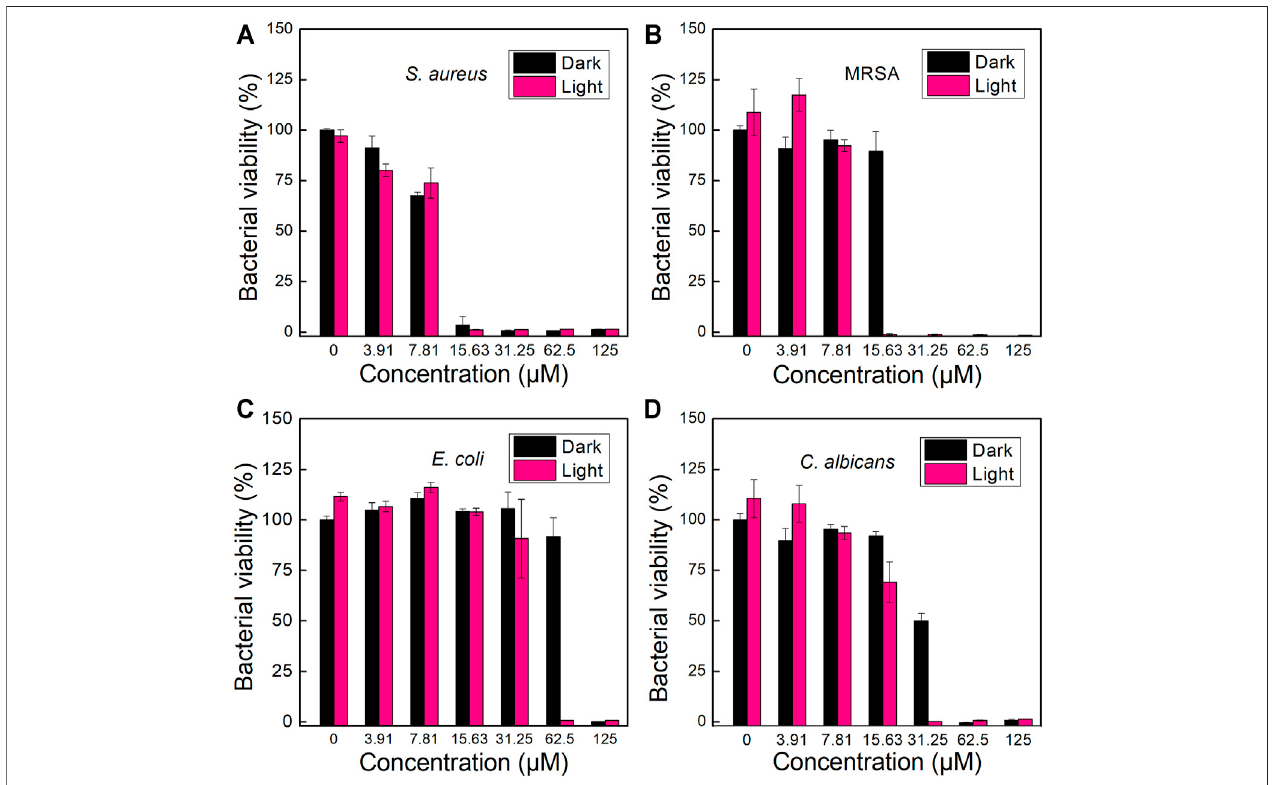
FIGURE 5 | Growth inhabitation of (A) S. aureus , (B) MRSA , (C) E. coli and (D) C. albicans on 96-well plates after incubation with different dosage of TPA-PyOH.